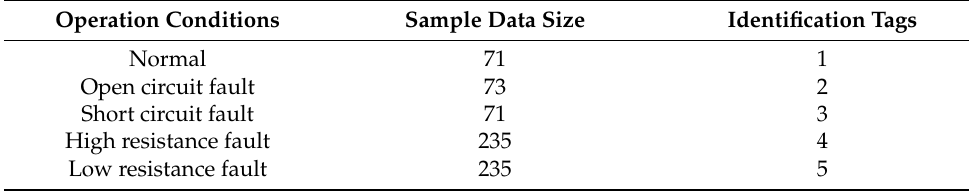
Table 3. Sample volume and code of cable fault types.